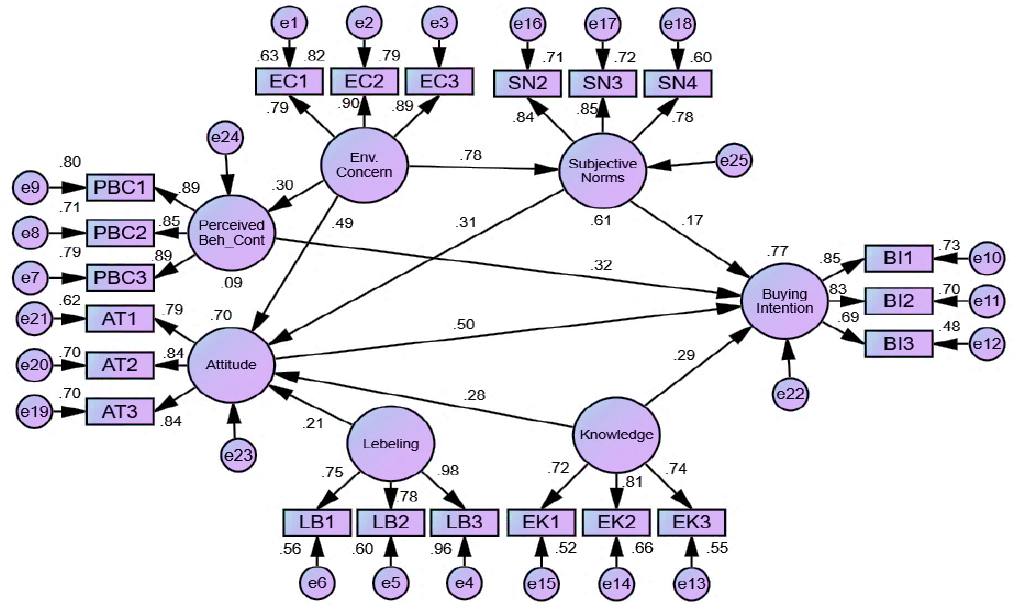
Figure 3. Structural Model [Source: Selected output of AMOS 21.0]. Table 8. Structural Model and the Hypothesis Testing Table 8 highlighted the statistic of path model using SEM via AMOS 21.0 software to